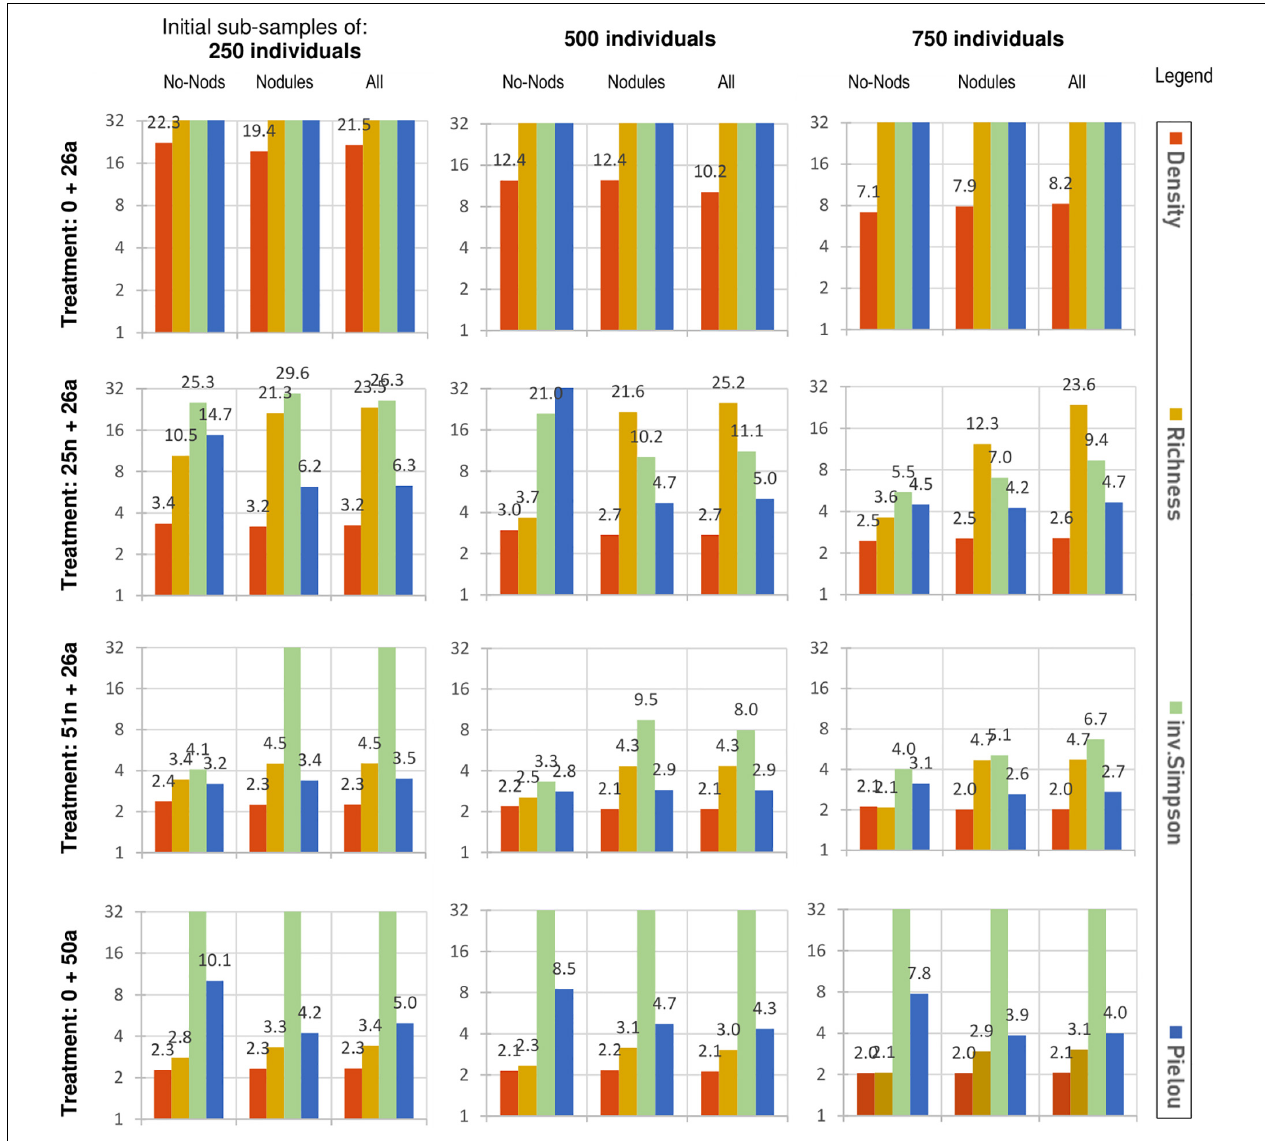
FIGURE 3 | Power analysis of the four metrics in Figure 2 above (rightmost labels), across three initial sub-sample sizes (250, 500, 750), under the four middle degradation treatments (leftmost legend, explained in Table 3 ), increasing in severity from top to bottom. Two-tailed t -test error thresholds: significance ≤ 0.05; power (type II confidence) ≥ 95%. The y-axis is logarithmic, depicting the theoretical number of sampling sites required to meet these error thresholds ( ≥ 2). Values greater than 32 are not fully displayed, as they would be impractical to implement. Additional metrics are displayed in Supplementary Figures S3, S4